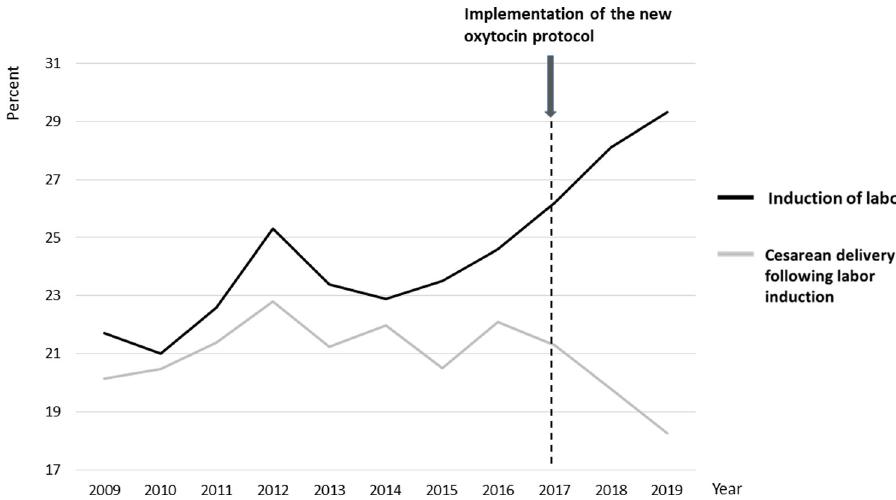
Fig 4. The rates of labor induction and emergency cesarean delivery in induced labor in Helsinki University Hospital 2009–2019. The rate of labor induction in Helsinki University hospital has steadily increased over the last decade. The rate of emergency cesarean delivery has decreased from 22.1% in 2016 to 18.3% in 2019 since the implementation of the new oxytocin protocol in January 2017 [12].